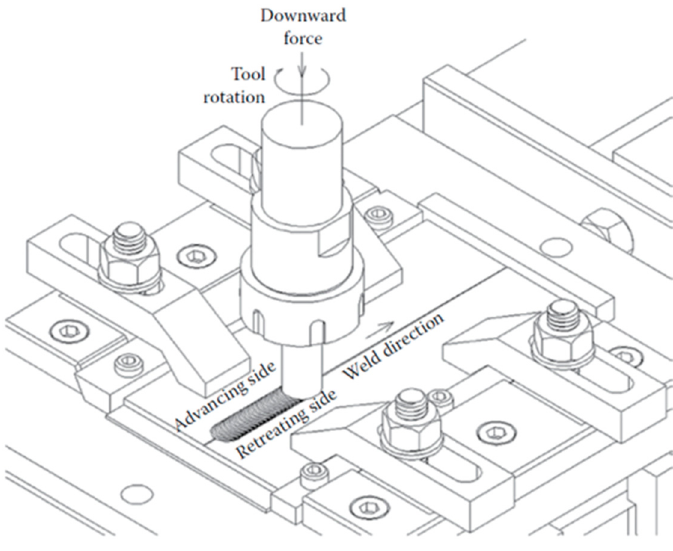
Figure 2. Schematic of FSW process [7].